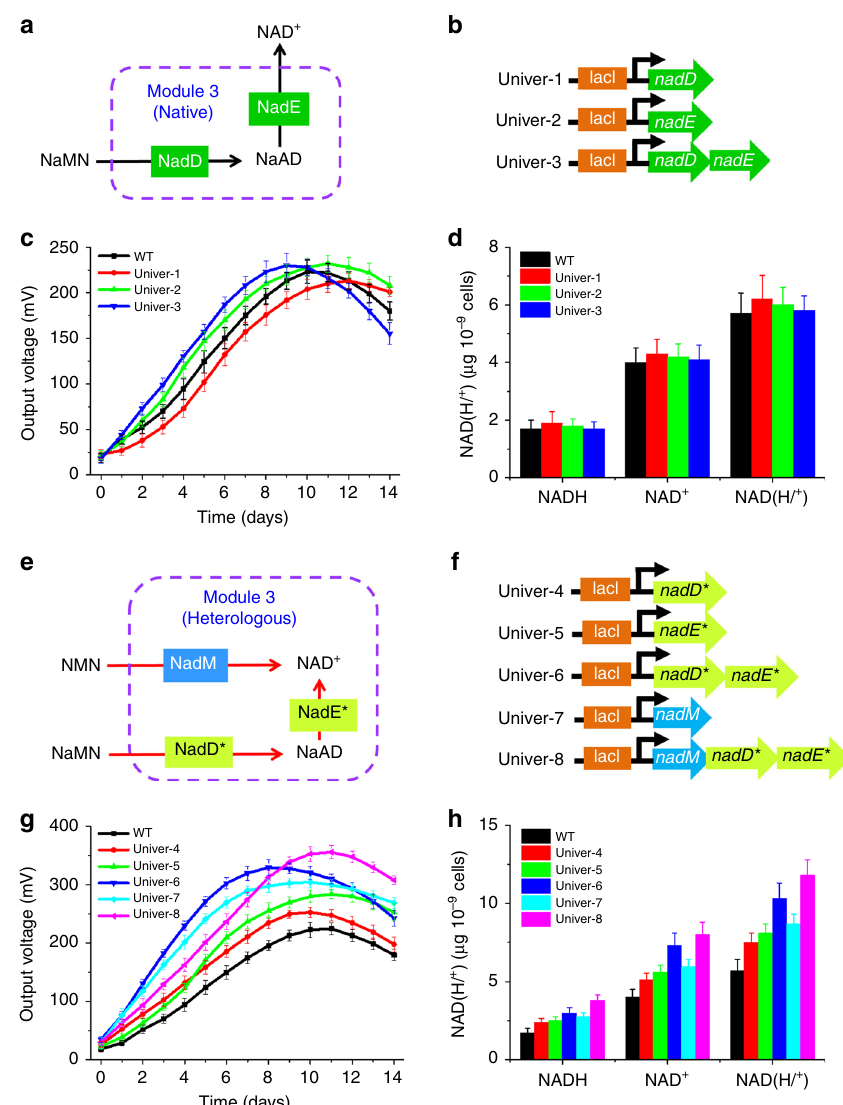
Fig. 4 Optimization of the universal biosynthesis pathway of S. oneidensis (Module 3). a A depiction of the overexpressed genes in the universal biosynthesis pathway (Module 3). b Plasmids that included the assemblage of genes ( nadD and nadE ) in the universal biosynthesis pathway of Module 3. c Voltage output in MFCs of the above S. oneidensis recombinant strains. d Quantitative measurements of the intracellular NAD + , NADH, and total NAD (H/ + ) levels of these strains under anaerobic cultures. e Rewiring the universal biosynthesis pathway by introducing a heterogeneous nadM pathway